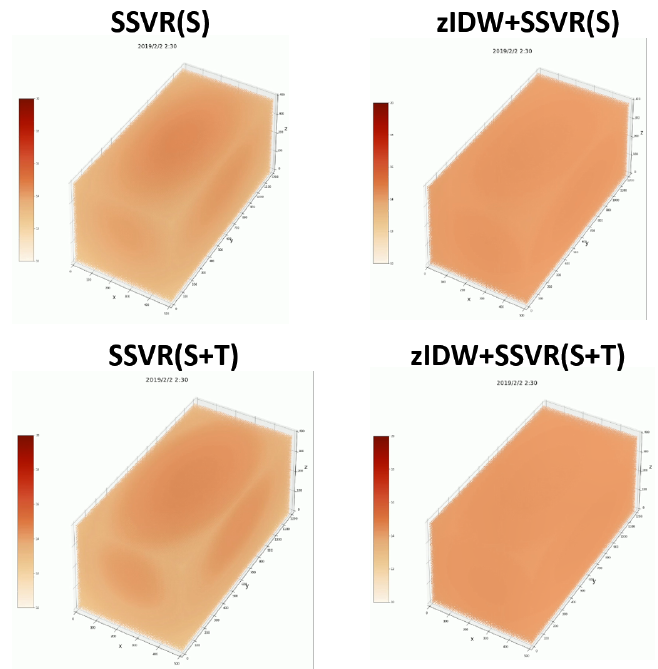
Figure 7. Heat maps comparison with four continuous monitoring models of